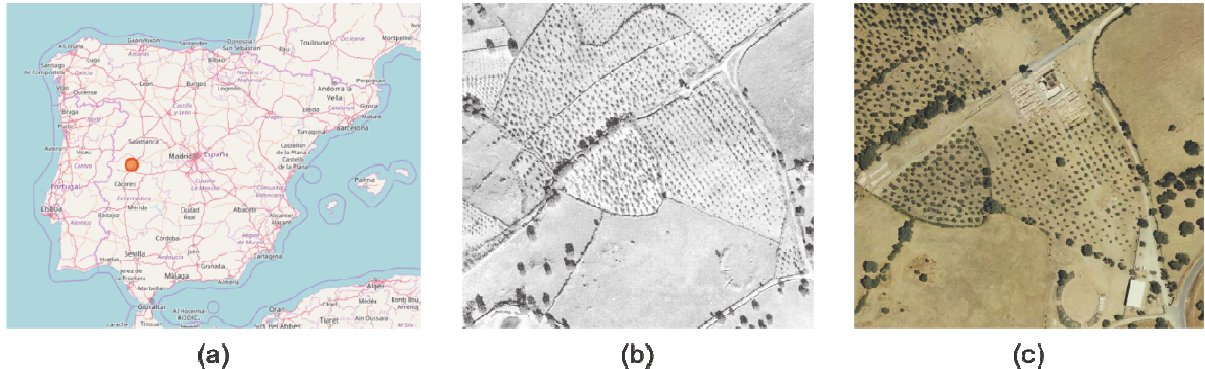
Figure 1. Situation map of the Roman City of Cáparra. (a) General view (source: OpenStreeMap). (b) Detail view: Aerial photograph from the interministerial flight 1973-1986 (Source: Instituto Geográfico Nacional). (c) Detail view: Orthomosaic from 2012 PNOA campaign (Source: Instituto Geográfico